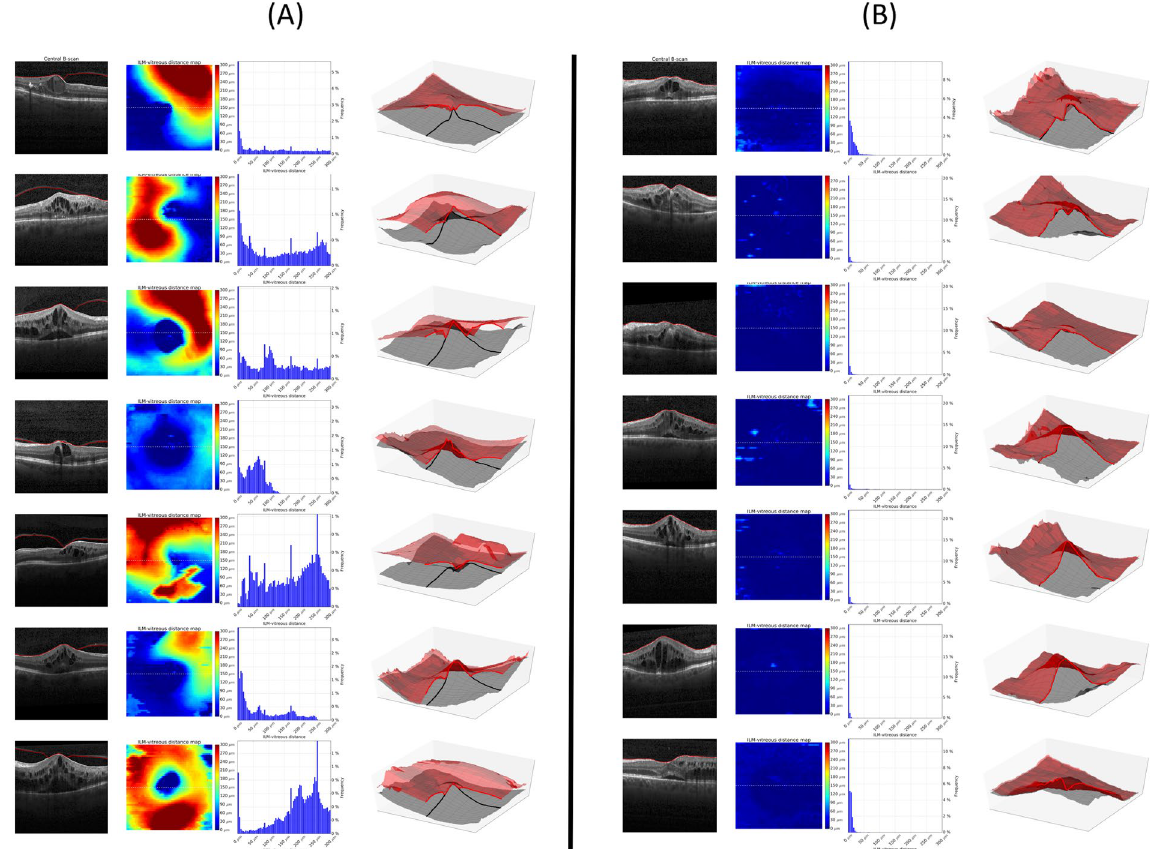
Figure 1. Fully automated segmentation of the posterior vitreous boundary in 3D optical coherence tomography. Panel (A) shows example patients with vitreomacular adhesion, Panel (B) illustrates eyes without vitreomacular adhesion. Far left: Central B-scan showing the segmentation obtained by the automated algorithm (red line = posterior vitreous boundary). Left: En-face map of the distance between the internal limiting membrane and the posterior vitreous boundary for the 6 × 6 mm optical coherence tomography volume. Right: Histogram of distances shown in the en-face map used as an input feature for unsupervised clustering. Far right: 3D visualization of the internal limiting membrane and the posterior vitreous boundary. The bold line in the 3D visualization corresponds to a 90° wedge being cut out of the volume; note that the line to the right of the image corresponds to the right half of the provided B-scan, while the part pointing towards the observer is perpendicular to the B-scan slice shown on the left.